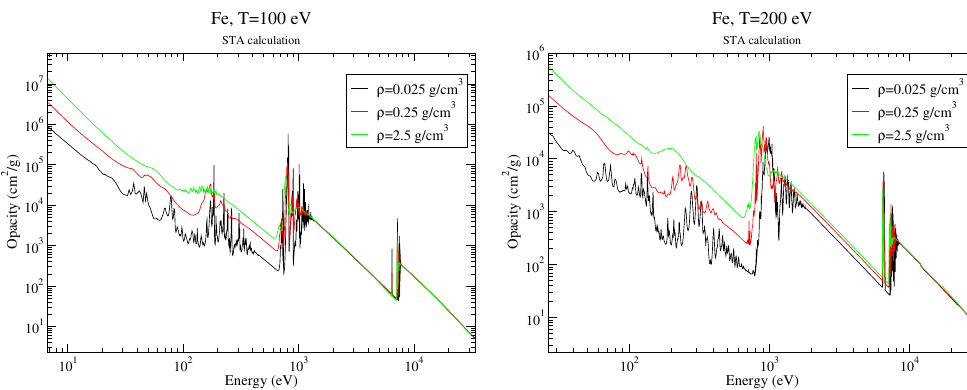
Figure 1. Opacity of an iron plasma at T = 100 eV ( left ) and T = 200 eV ( right ) and ρ = 0.025, 0.25, and 2.5 g cm − 3 . ·